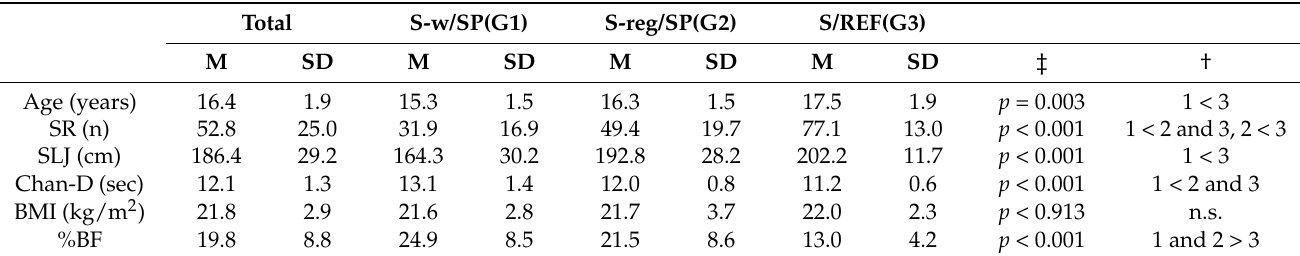
Table 1. Descriptive statistics on age, physical fitness tests, and body composition according to differ- ent groups (students without sports practice—G1; students involved in regular sports practice—G2; student referees—G3).